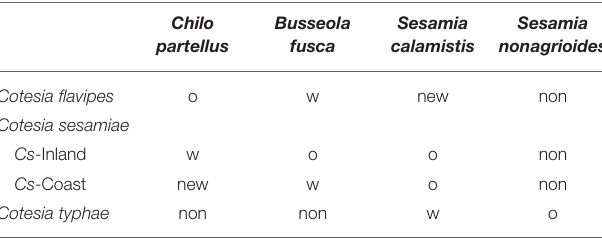
TABLE 1 | Suitability of lepidopteran stem borer species to different Cotesia species and strains based on field observations and the